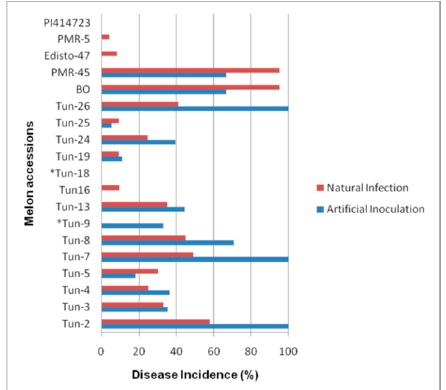
Figure 4. Disease incidence (%) of melon landraces and control genotypes evaluated to P. xanthii Race 2, under natural infection and under artificial inoculation. ‘Bola de Oro‘ (BO) and ‘PMR-45‘ were the susceptible controls; ‘Edisto-47‘, ‘PMR-5‘, and ‘PI414723‘ were the resistant controls. *Tun-9 and *Tun-18 were not evaluated under natural infection due to poor numbers of available seeds.